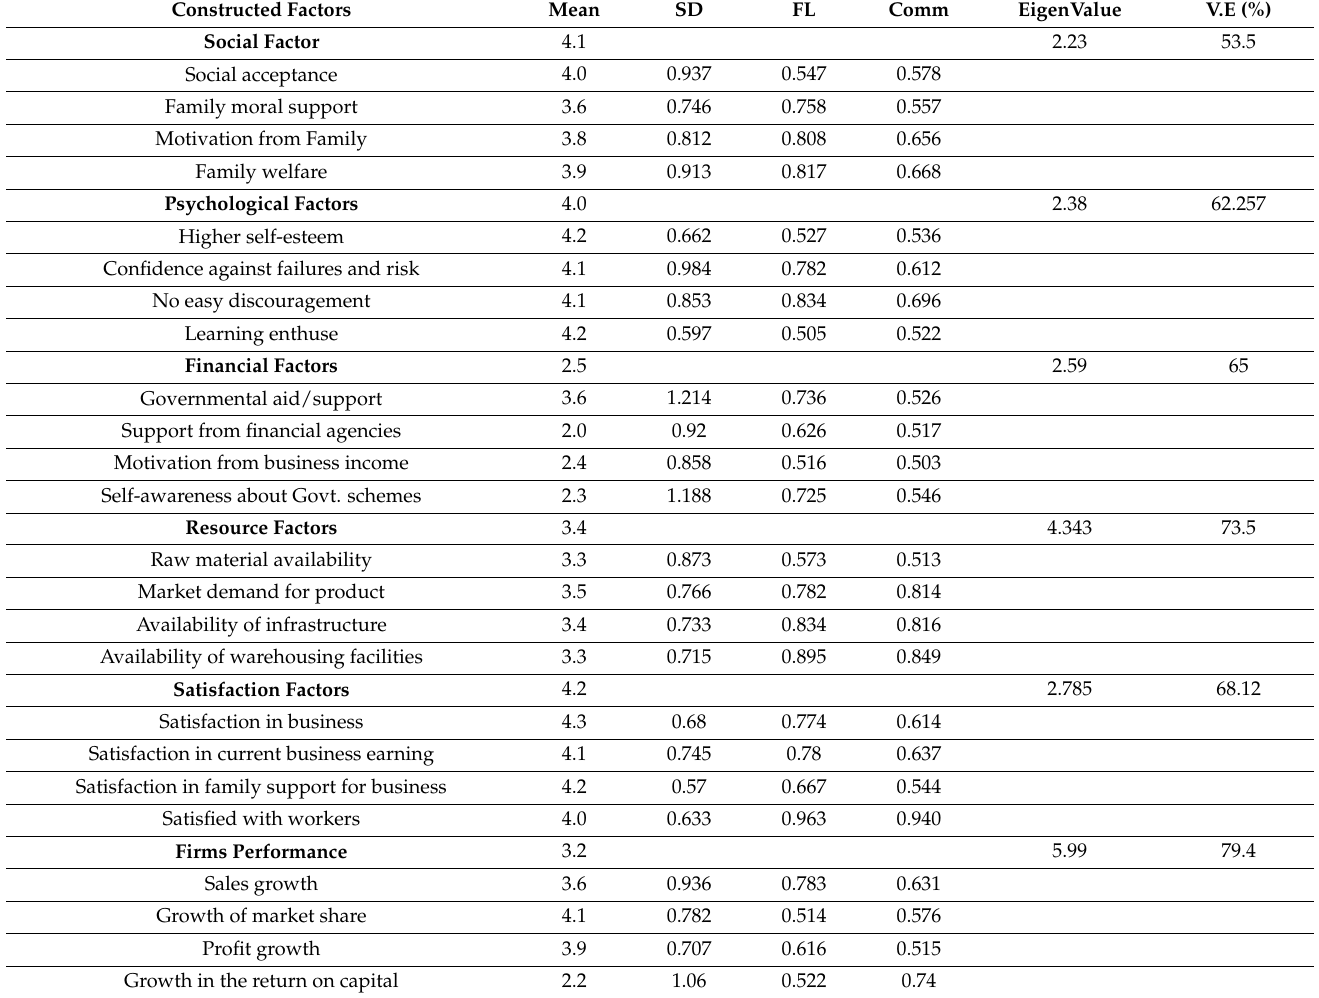
Table 2. Summary of exploratory factor